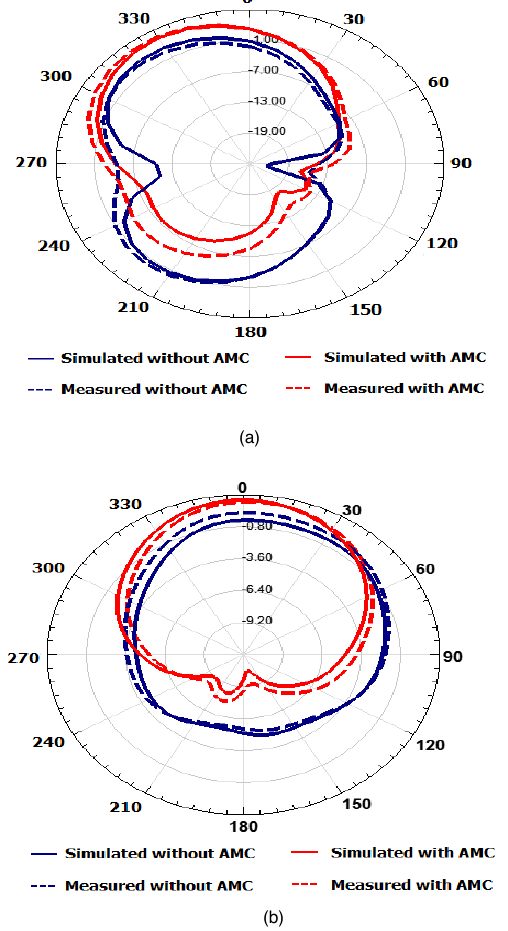
FIGURE 10. Radiation patterns of the proposed CP MIMO antenna with AMC at 2.45 GHz simulated vs. measured (a) E-Plane (b)